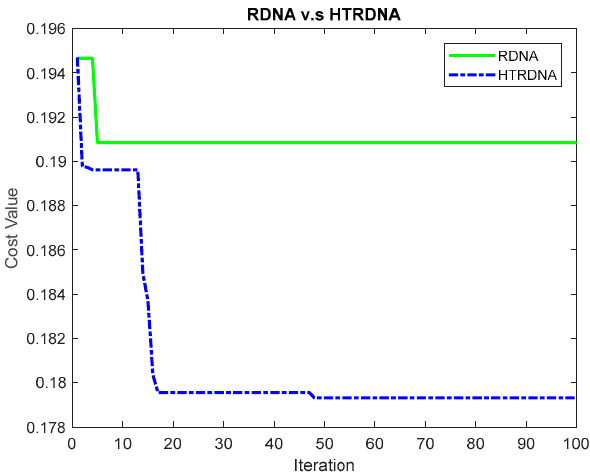
Figure 11. Error between unknown and estimated perturbations.